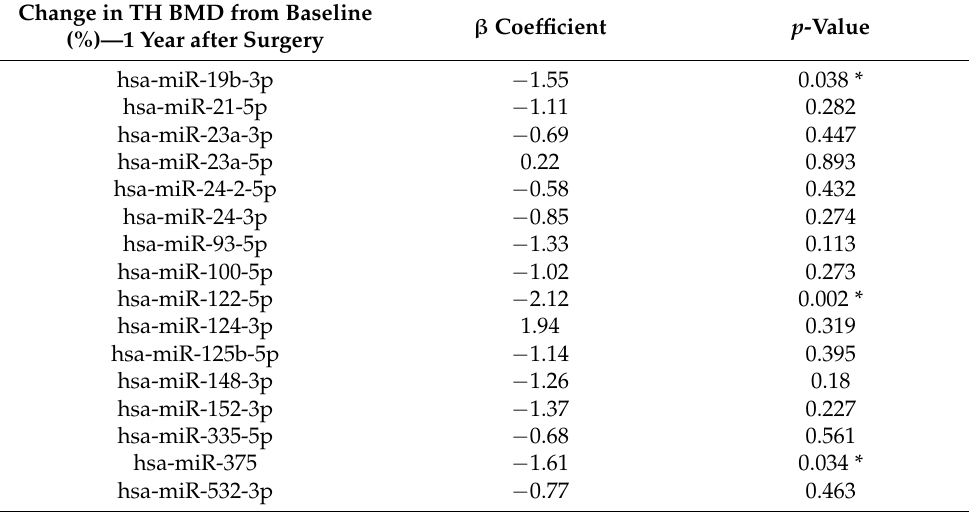
Table 2. Univariable regression ( β coefficient) for the association of log-transformed preoperative